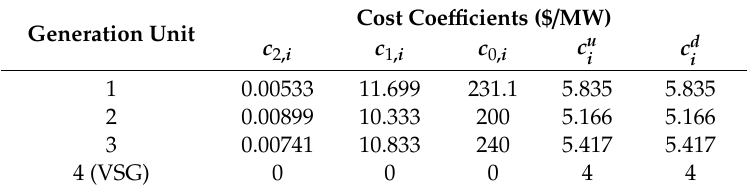
Table 4. Predicted renewable generation and load.